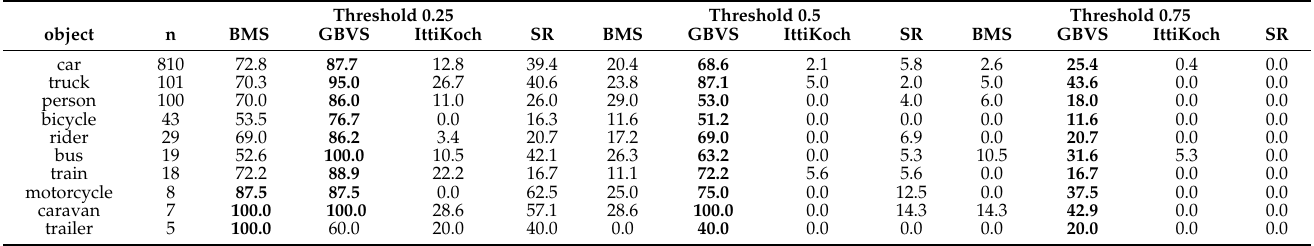
Table 5. Percentage of salient objects with respect to the total number of instances over different saliency thresholds. The column n shows the total number of object instances in the dataset. The saliency model with the largest percentage of salient instances within each threshold is emphasized.